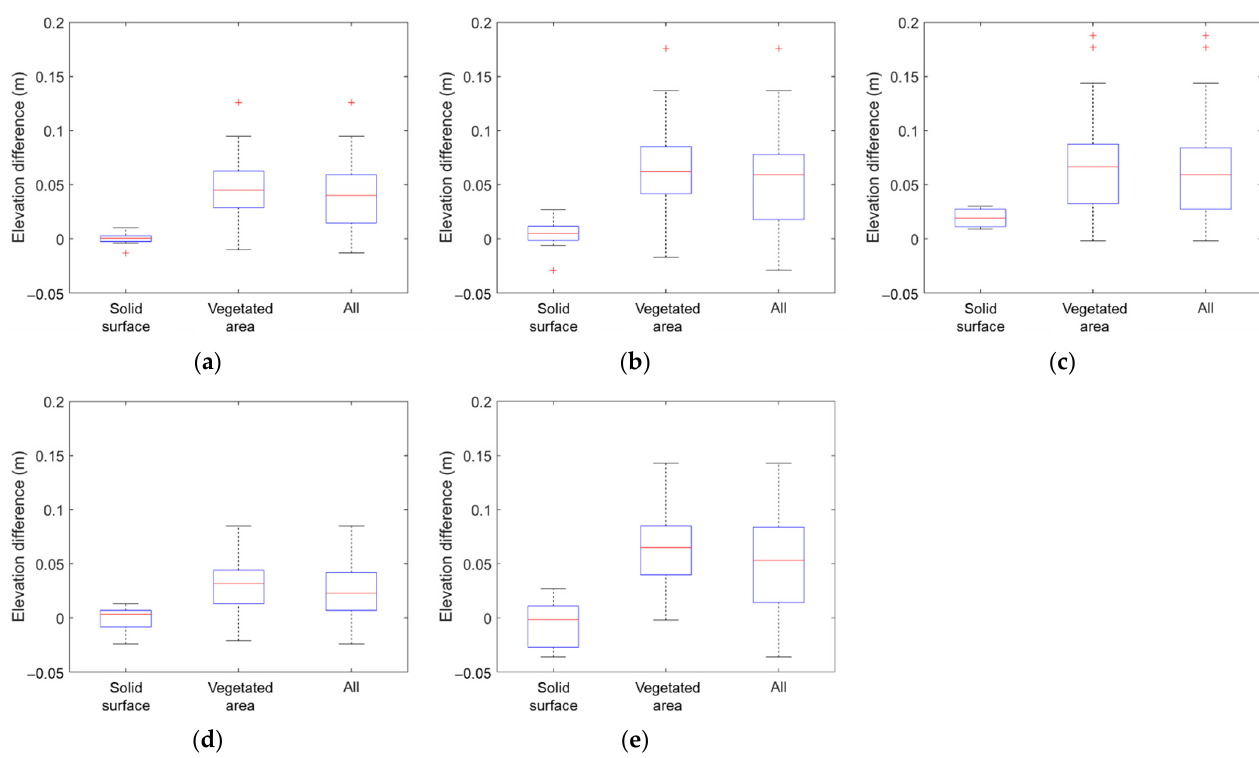
Figure 16. Statistics of elevation difference between RTK-GNSS surveyed points and LiDAR points for ( a ) PWMMS-HA, ( b ) PWMMS-UHA, ( c ) UGV, ( d ) Backpack, and ( e ) Mobile-pack with residual plots of range, 25th percentile, median, and 75th percentile.